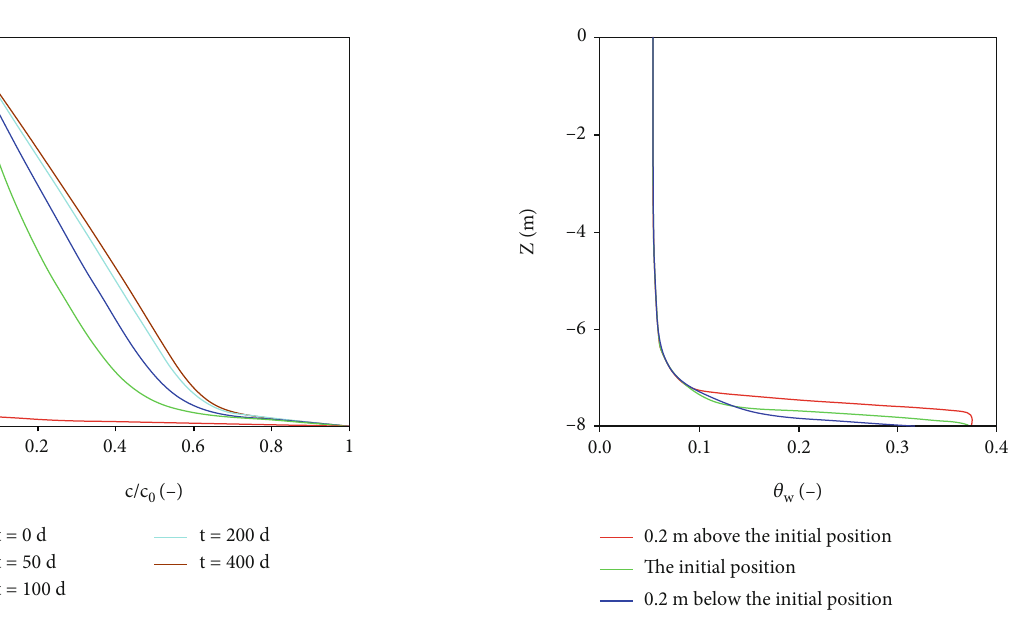
Figure 5: Vertical distributions of soil moisture content at x = 10 m under the dynamic equilibrium